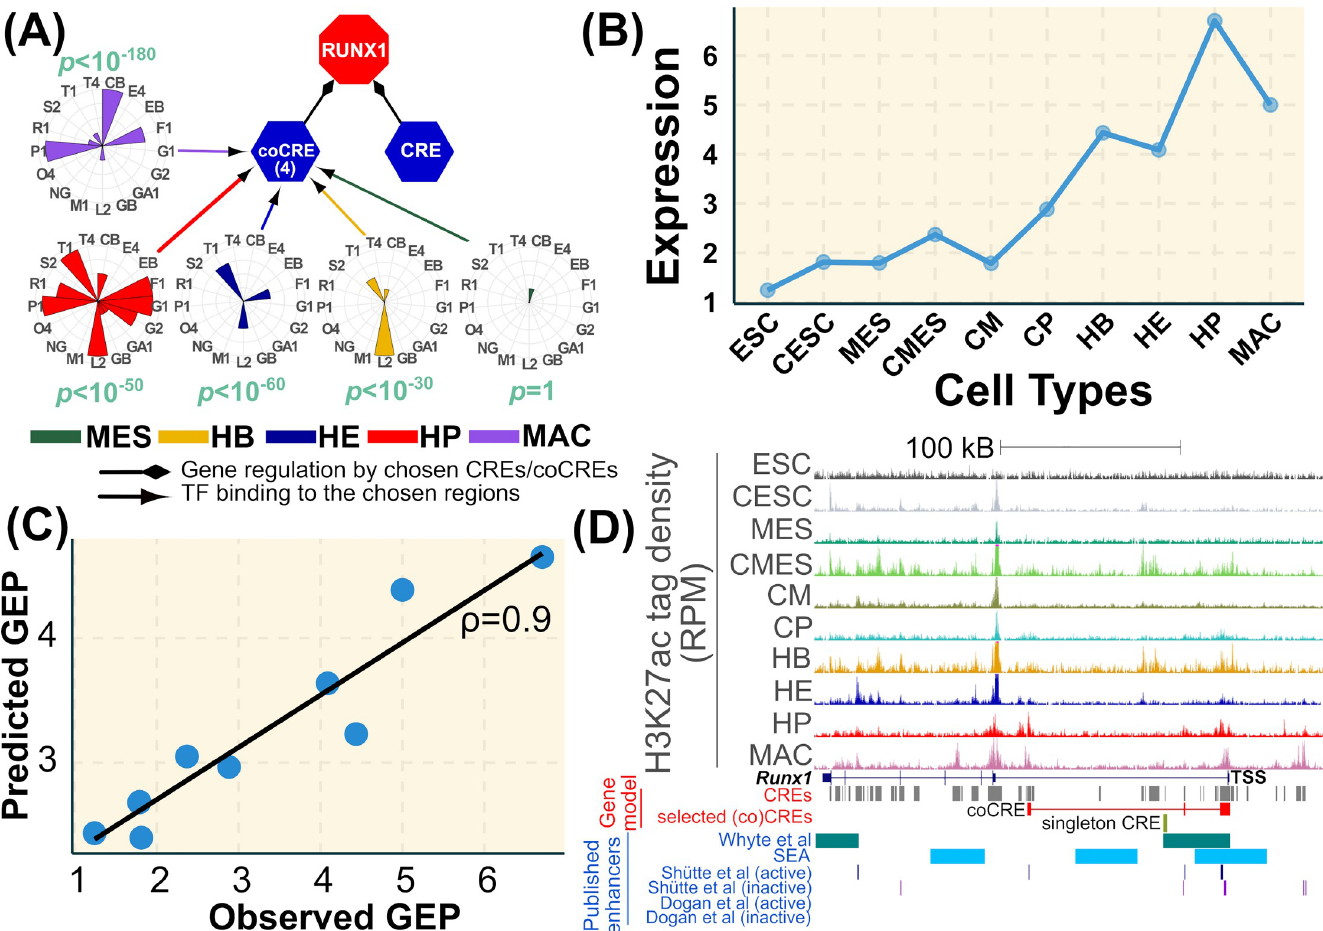
Fig 2. Predictive model for an example gene, Runx1. (A) A network representation of the model, where the gene (here Runx1 ) for which the model is built (red octagon), chosen CREs (blue hexagons) and TFs bound to the chosen CREs are represented as nodes. Black arrows indicate the regulation of the gene by the CRE/ coCRE and coloured arrows represent the binding of TFs to the CREs in different cell types. The colours corresponding to the cell types are given below the network. The TFBP of the CRE in a specific cell type is represented as a circular histogram and in the case of coCREs these represent the frequency of occurrence of a specific TF in the regions of that community (here the community comprises of 4 regions). The p -value of observing a combinatorial binding profile in that cell type is provided for each TFBP node and the methodology is given in Methods section. The abbreviations for the TFs in the circular histogram are: Esrrb (EB), Nanog (NG), Pou5f1 (O4), Sox2 (S2), Cebpb (CB), Elk4 (E4), Gata2 (G2), Lmo2 (L2), Tal1 (T1), Fli1 (F1), Tead4 (T4), Meis1 (M1), Gata1 (GA1), Gfi1 (G1), Gfi1b (GB), Runx1 (R1), Spi1 (P1). It should be noted that not all TFs in the circular histogram have supporting ChIP-seq data in all cell types (Table 1). In the absence of ChIP-seq data for a specific cell type, the bar for that TF in the histogram of that cell type is zero. (B) The gene expression profile (GEP) of Runx1 with cell types along the horizontal axis and FPKM on the vertical axis. (C) The plot shows the best linear fit between the actual (X) and predicted (Y) GEP for Runx1. The spearman correlation coefficient is also provided. (D) The plot shows the tag density profile normalised as coverage per million aligned reads for the 10 cell types. Runx1 gene structure is provided in blue below the coverage tracks. The predictor CREs that were used in the lasso model are given as grey boxes and the chosen CRE and the coCRE are given in red and yellow respectively. The super enhancers (SE) identified by Whyte et al.[53] are given as green bars and the enhancers given by SEA is in blue. The experimental enhancers identified by Schu¨tte et al. and Dogan et al. are provided as well. In the case of Runx1 there is no overlap with the Dogan et al. dataset, and hence the absence of any bars. It should be noted that the coCRE enhancer is represented as a composite of red boxes of member CREs.